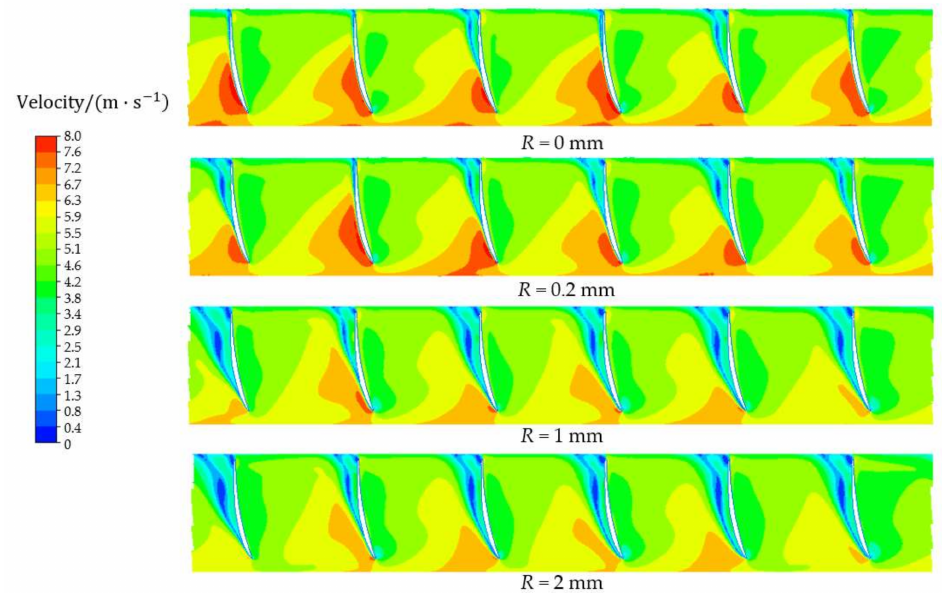
Figure 16. Cylindrical distribution of guide vane internal velocity under pump conditions ( r ∗ = 0.99).